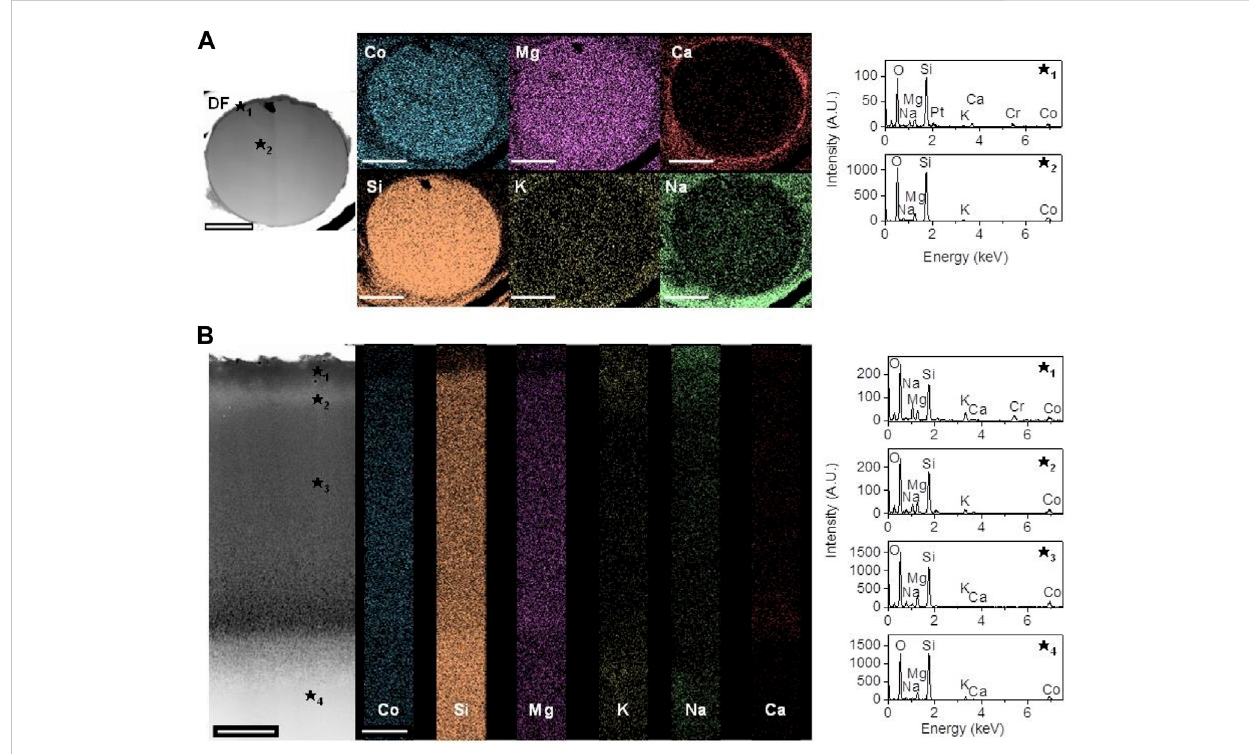
FIGURE 4 Dark fi eld TEM images and EDX spectra of a 5Co fi bre cross section (A) and 5Co particle (B) showing several reaction layers with differing elemental concentrations after incubation in DMEM for 7 days. Scale bar for (A) is 1 µm for (B) is 250